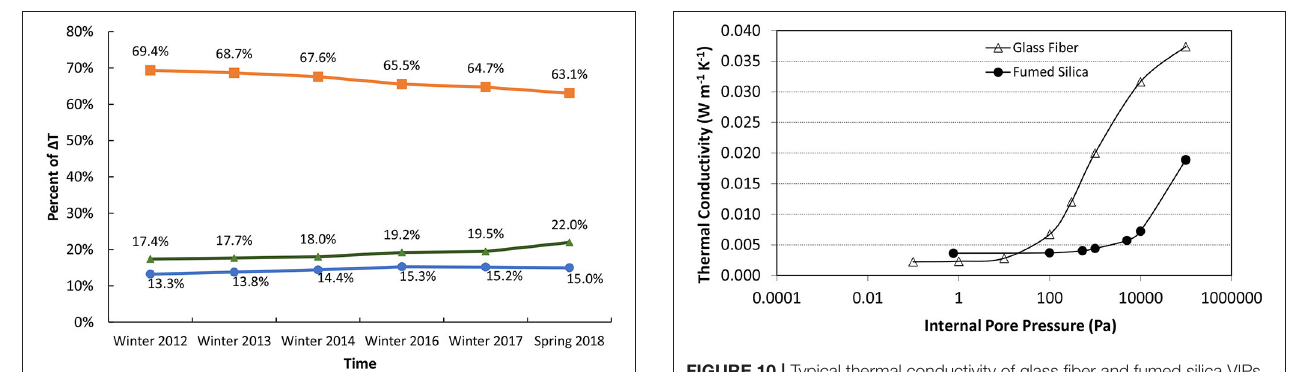
FIGURE 10 | Typical thermal conductivity of glass fiber and fumed silica VIPs as a function of internal pore gas (air) pressure (Heinemann, 2017).